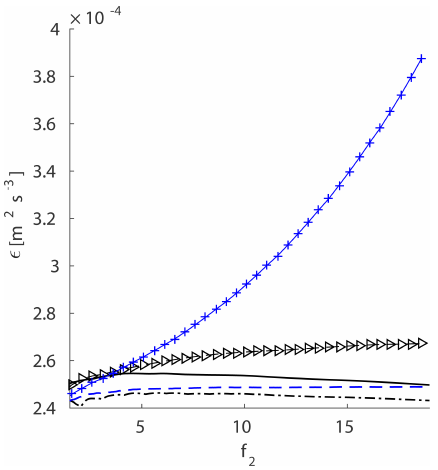
Figure 7. Values of the dissipation rate from simulation analysis as a function of higher value of the fitting range f 2 estimated based on the averaged profiles from Fig. 6 of the following: S(f ) , where the blue dashed line is the synthetic 200Hz signal and the blue line with + symbols is the 40Hz synthetic signal; N 2 solid line is the 200Hz synthetic signal and the line with (cid:70) symbols is the 40Hz synthetic signal; and N 2 the filter response correction – black dot-dashed line. The input (cid:15) = 2 . 5 × 10 − 4 m 2 s − 3 .